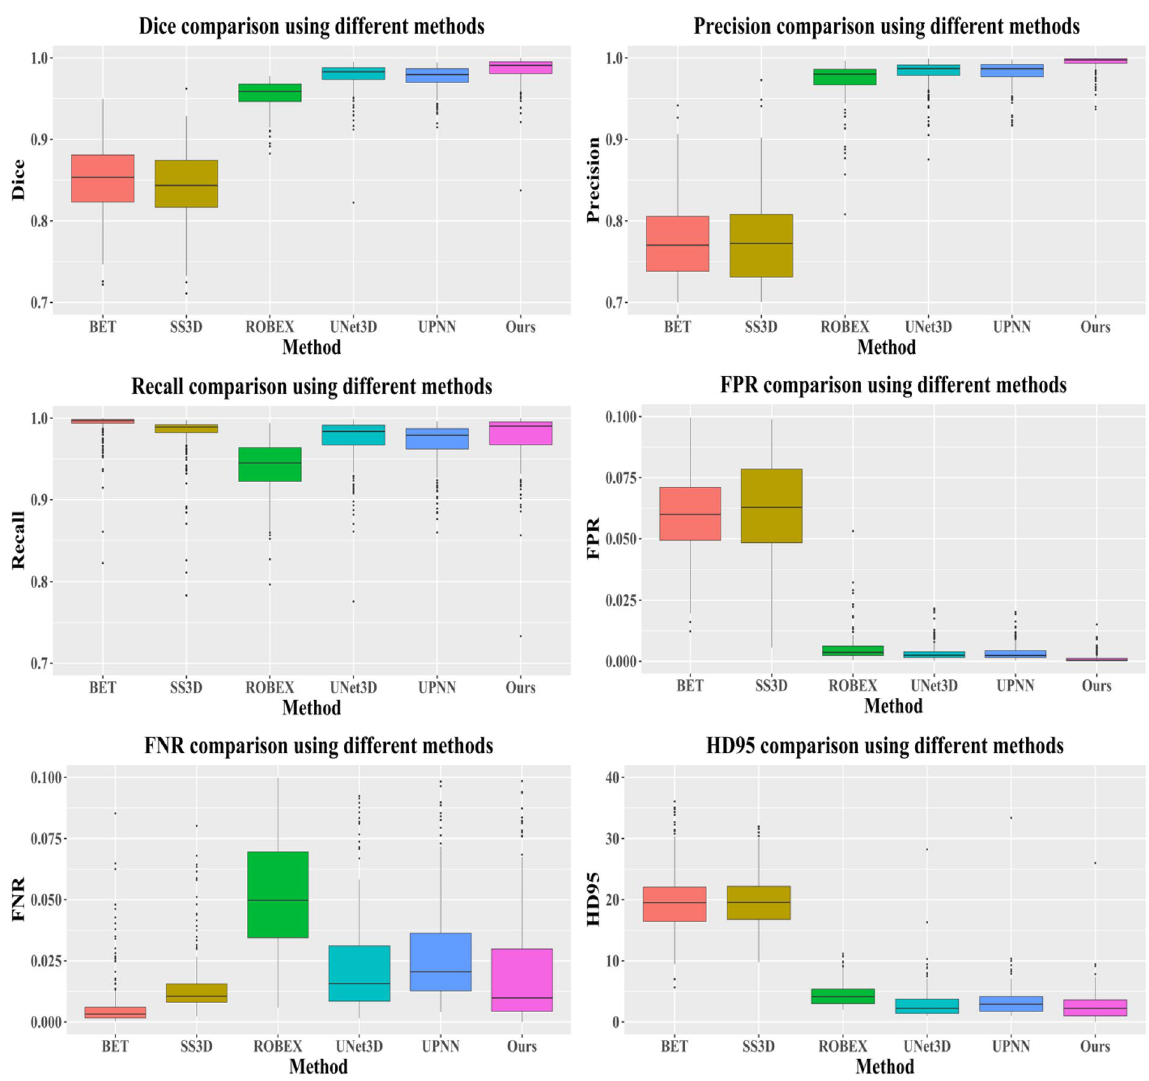
Figure 5. Box plot of performance comparison to state-of-the-arts on dice (top left), precision (top right), recall (middle left), FPR (middle right), FNR (bottom left), and HD95 (bottom right),